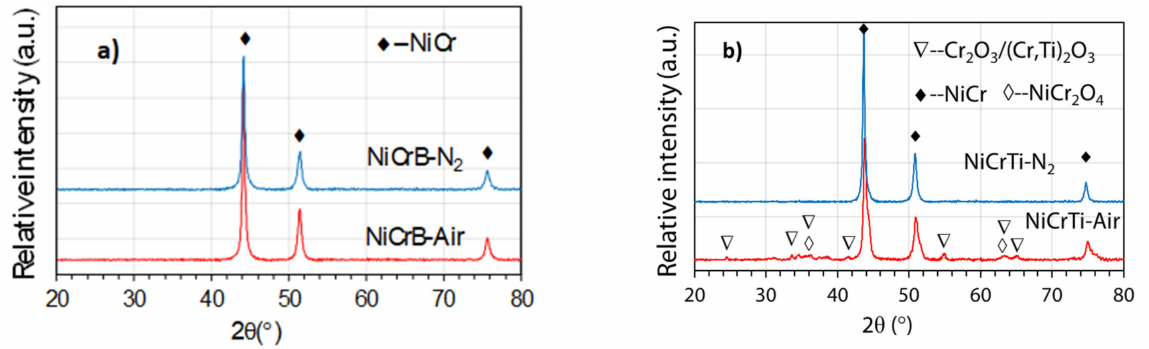
Figure 1. XRD patterns of as-sprayed ( a ) NiCrB and ( b ) NiCrTi coatings with air-atomized and